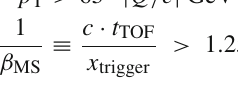
defined with respect to the online